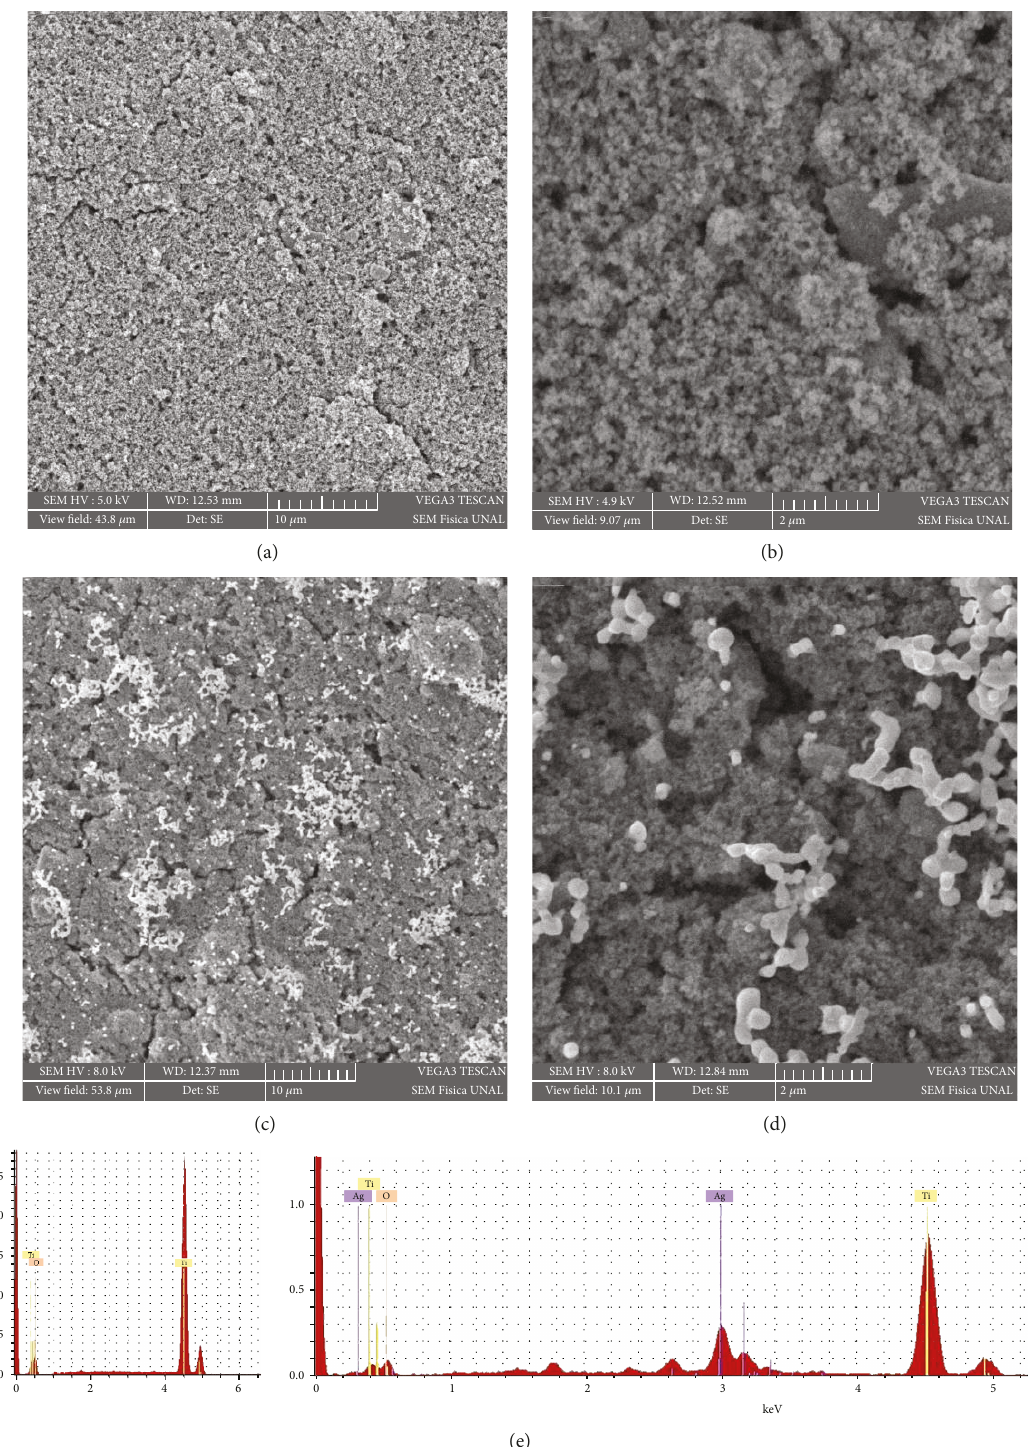
Figure 2: SEM images: (a) TiO Ag-TiO Ag thin fi lm EDS 2